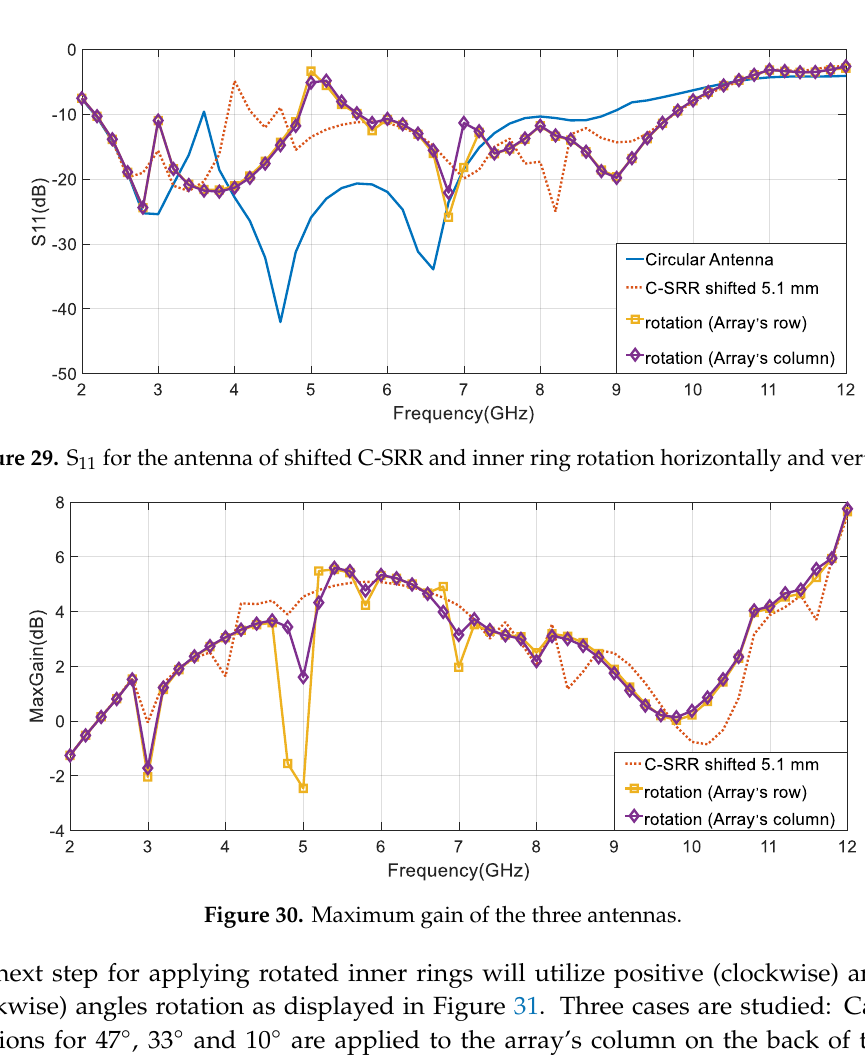
Figure 28. Inner ring rotation for C-SRRs.